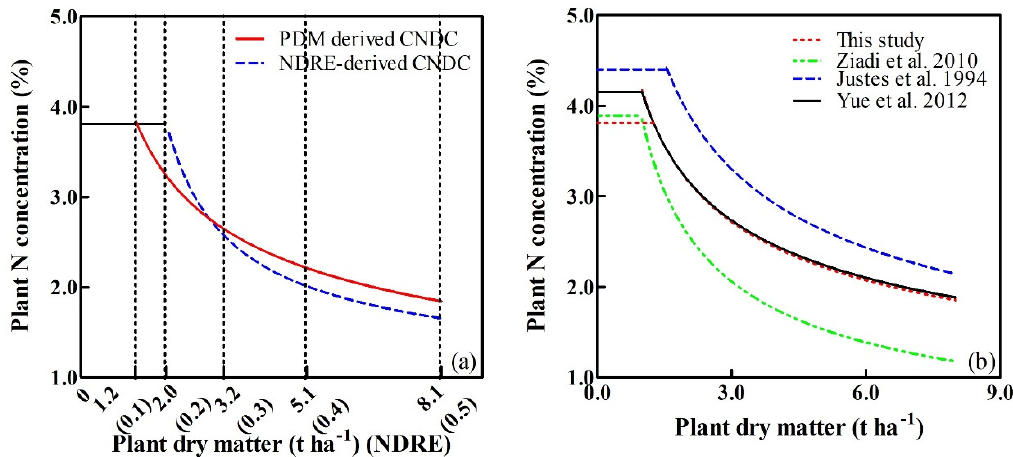
Figure 9. ( a ) Comparison of critical N dilution curves based on winter wheat NDRE and PDM. Intervals on the horizontal axis for NDRE were transformed so that the NDRE values coincided with the exponentially increasing PDM. ( b ) Comparison of different critical N dilution curves based on PDM in wheat.